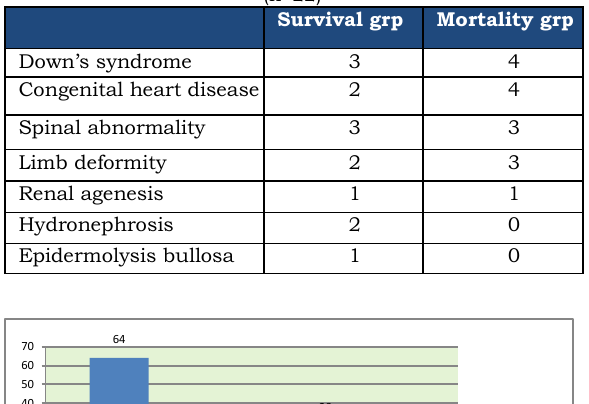
Table 2: Frequency of congenital anomalies in our patients (n=22) Survival grp Mortality grp